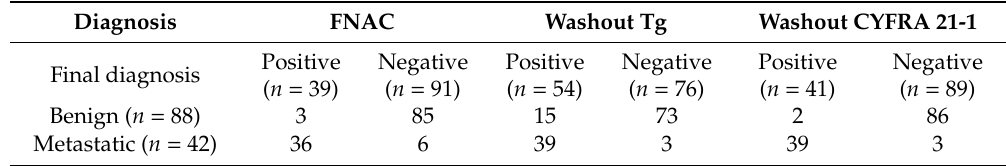
Table 2. Correlation of FNAC, washout Tg and washout CYFRA 21-1 of 130 LNs by final